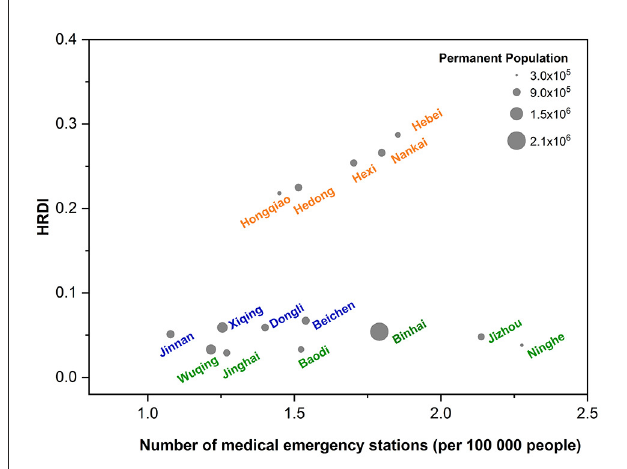
FIGURE2 Equity in EMS supply in Tianjin. HRDI, health resource density index. The orange font represents urban areas (Heping, Hexi, Hedong, Nankai, Hebei, and Hongqiao districts); the blue font represents sub-urban areas (Dongli, Xiqing, Jinnan, and Beichen districts); and the green font represents rural areas (Baodi, Wuqing, Ninghe, Jinghai, Jixian, and Binhai districts).